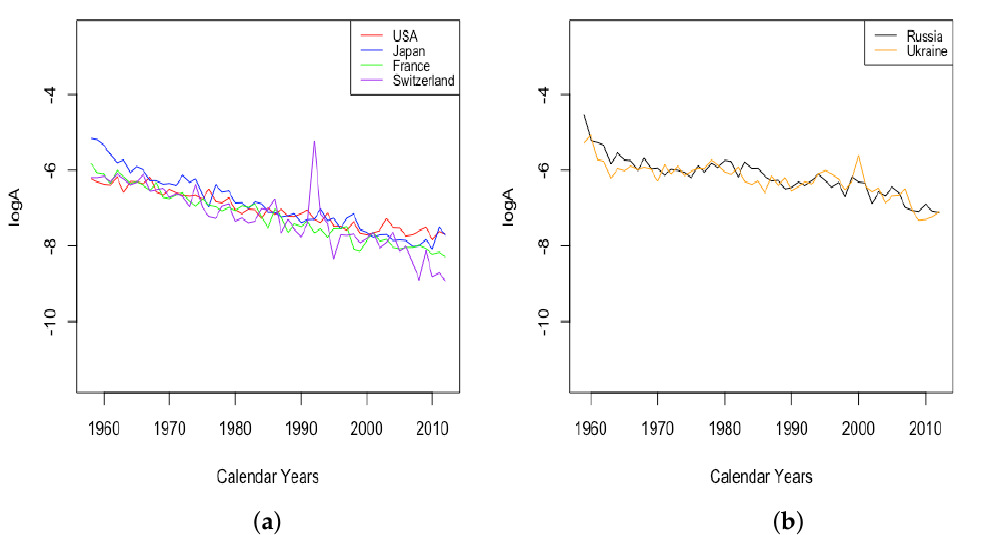
Figure 3. ( a ) The log of infant mortality A for females from 1959 to 2013 across HLE countries. ( b ) The log of infant mortality A for females from 1959 to 2013 across ILE countries.